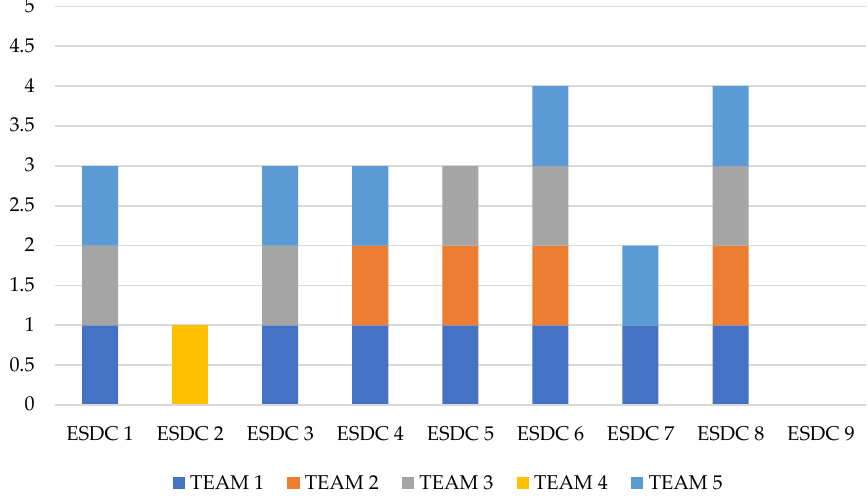
Figure 1. Accumulate graph of ESDC developed by each work team in their didactic proposals.